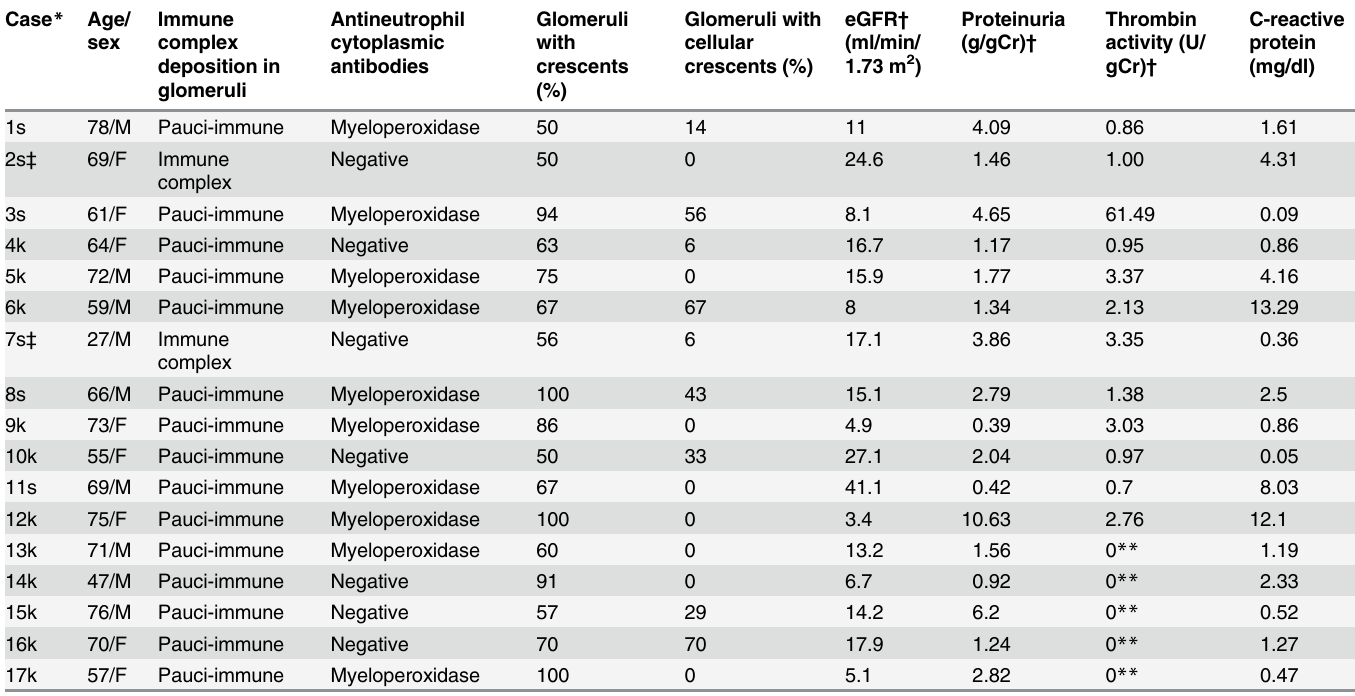
Table 2. Characteristics of patients with crescentic